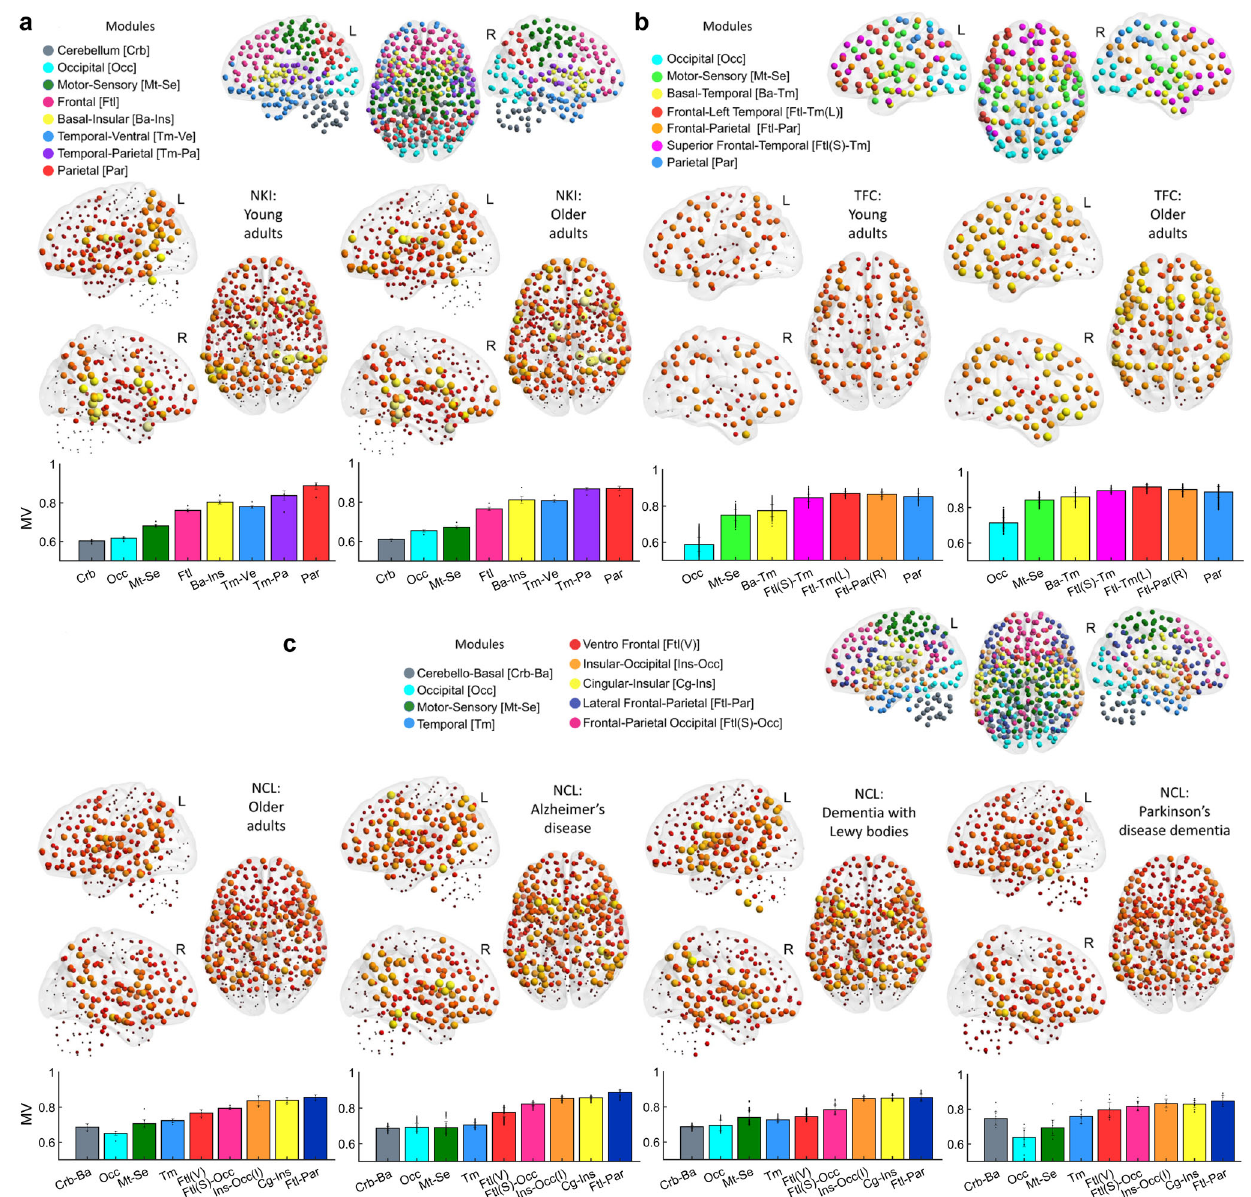
Fig. 3 Modular variability (MV), consensus communities and group means. a Nathan Kline Institute (NKI) consensus modularity and module de fi nitions shown in coloured spheres (top). Group mean MV for young adult (YA) and older adult (OA) groups (middle). Mean MV per module is shown as bar plots for the OA and YA groups (bottom); colours for each bar match the communities. b Same as ( a ) but for the 1000 functional connectome (TFC) cohort. c Same as ( a ) for the Newcastle (NCL) cohort. The left hemisphere (L), right hemisphere (R). Results presented here used the 451-ROI atlas for the NKI and NCL cohorts at optimal edge density; for results using other atlases see Supplementary Fig 5. The mean values and standard deviations shown in the bar plots are obtained by 500 times with bootstrapping